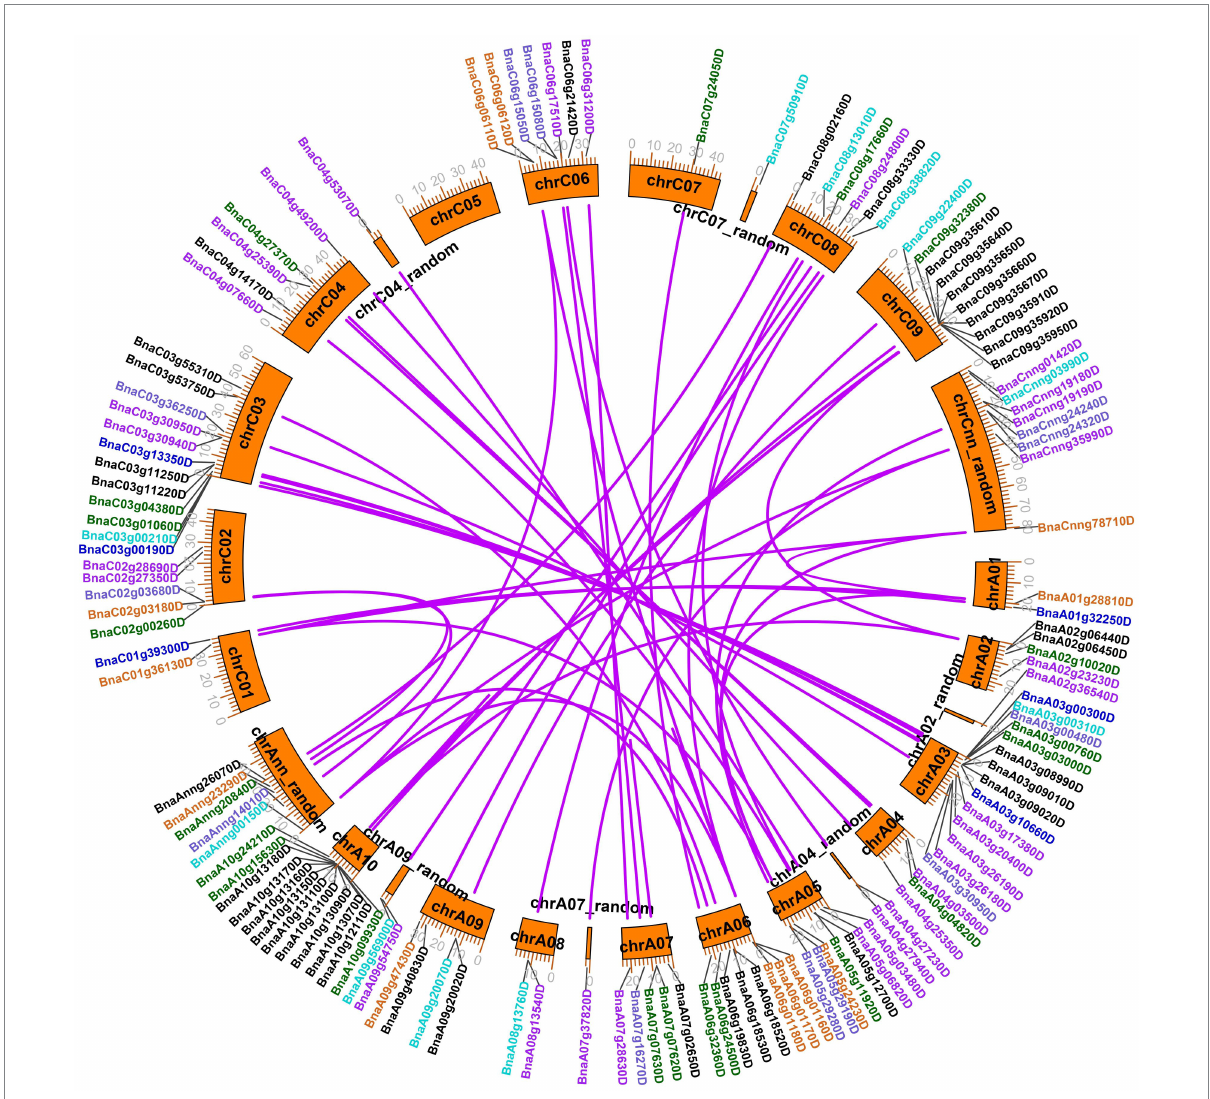
FIGURE 1 Chromosomal locations and duplicated gene analysis of BnLegLu genes in Brassica napus . The chromosomal locations of all BnLegLu genes are represented on different chromosomes, and different colors represent different BnLegLu subfamily genes. Subfamilies I to VII are indicated by black, purple, medium blue, dark turquoise, dark green, chocolate and slate blue color, respectively. Rose red lines are used to highlight the duplicated BnLegLu gene